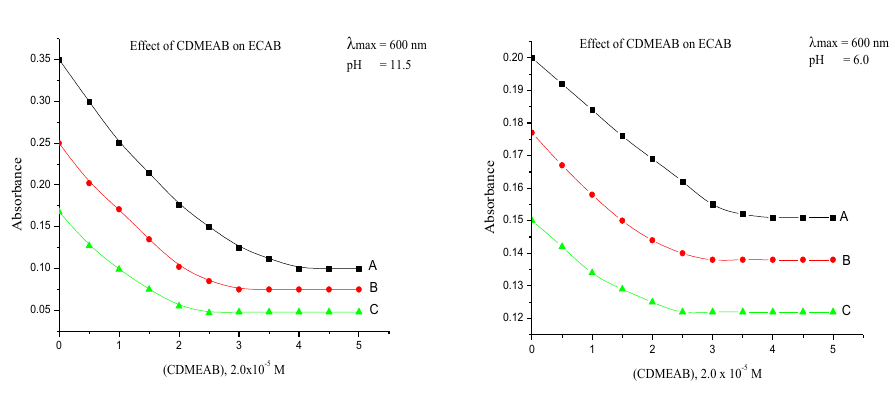
Figure 2. Effect of CDMEAB on ECAB in acidic medium.